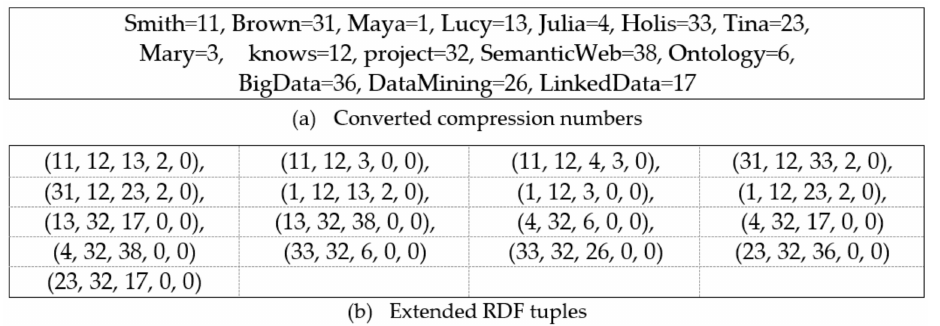
Figure 4. Converted compression numbers and extended resource description framework (RDF) tu- ples.